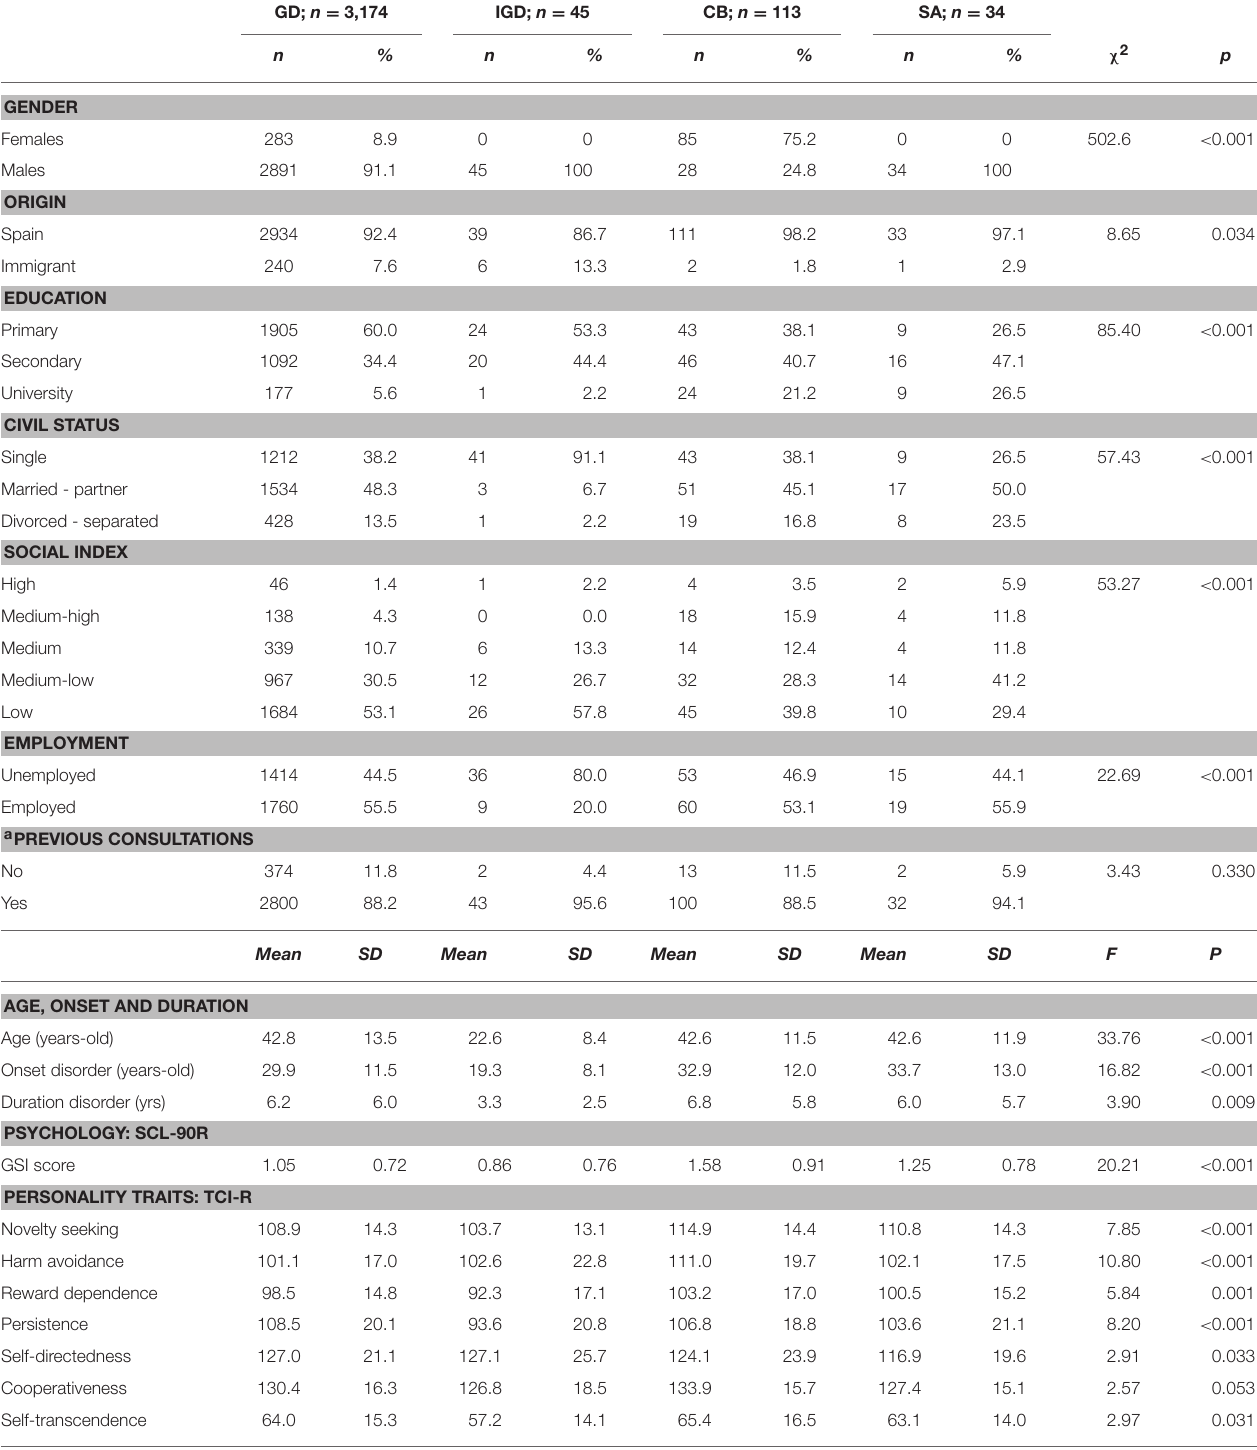
TABLE 1 | Sample description: sociodemographic and clinical